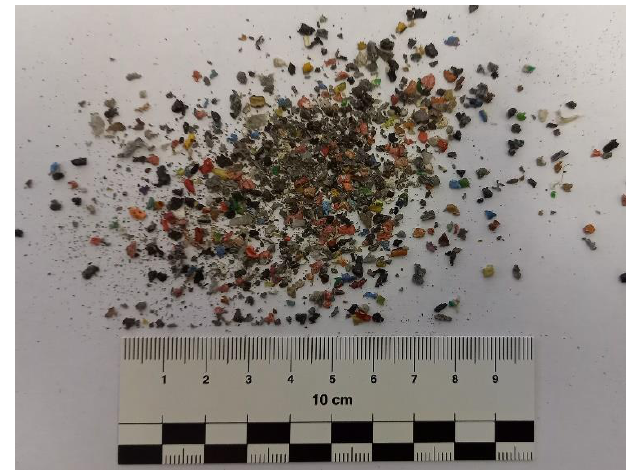
Figure 2. Studied cable waste.